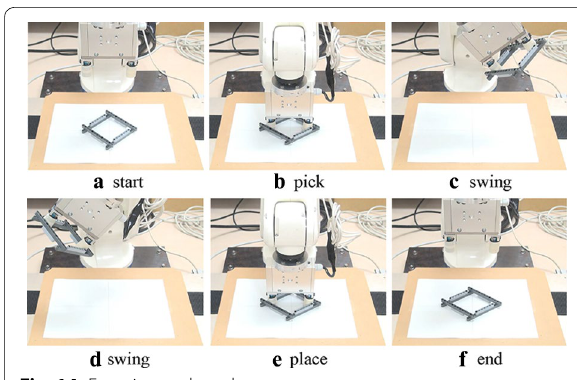
Fig. 14 Experimental results